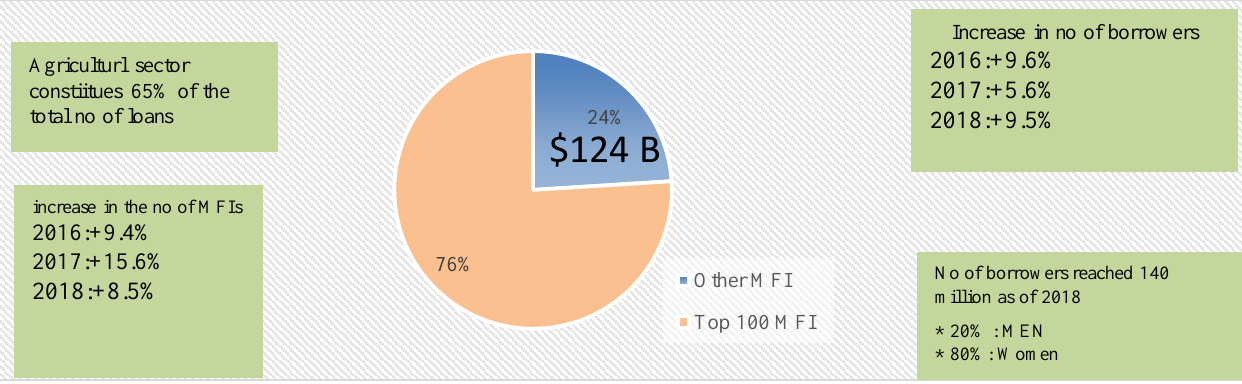
Figure 1: Worldwide MFI